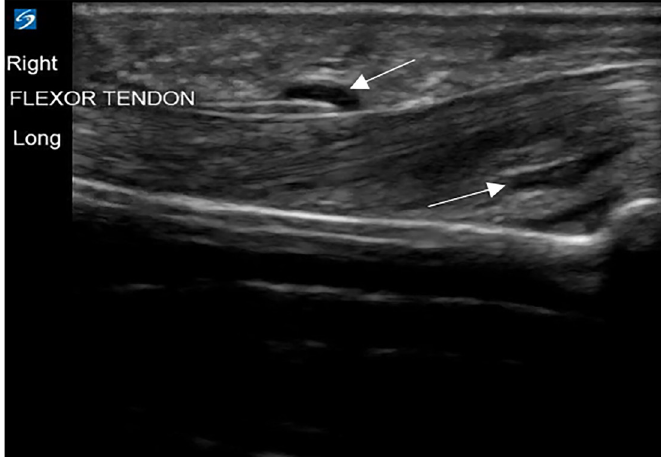
Image 3. Longitudinal ultrasound view of the right middle finger. The image displays the striated flexor tendon with anechoic fluid (white arrows) above and below the